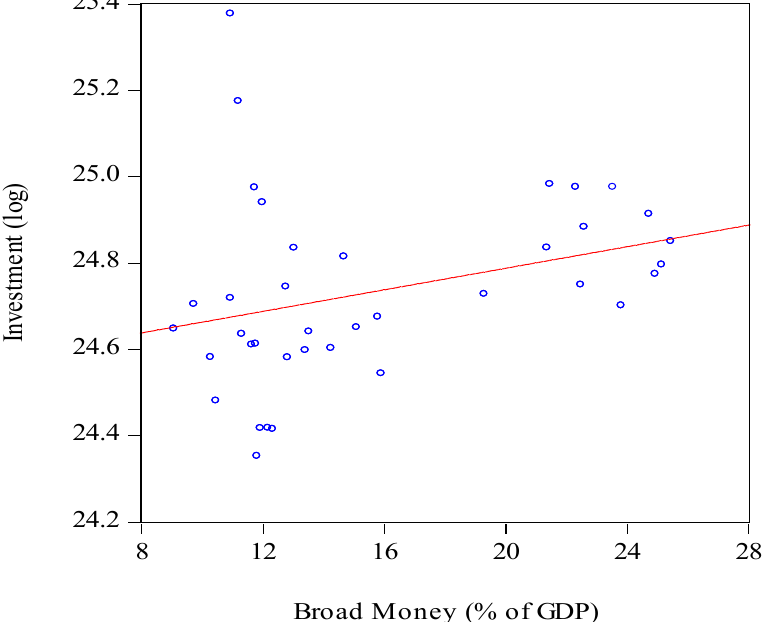
Fig. 2. Investment and broad money, the author’s computation